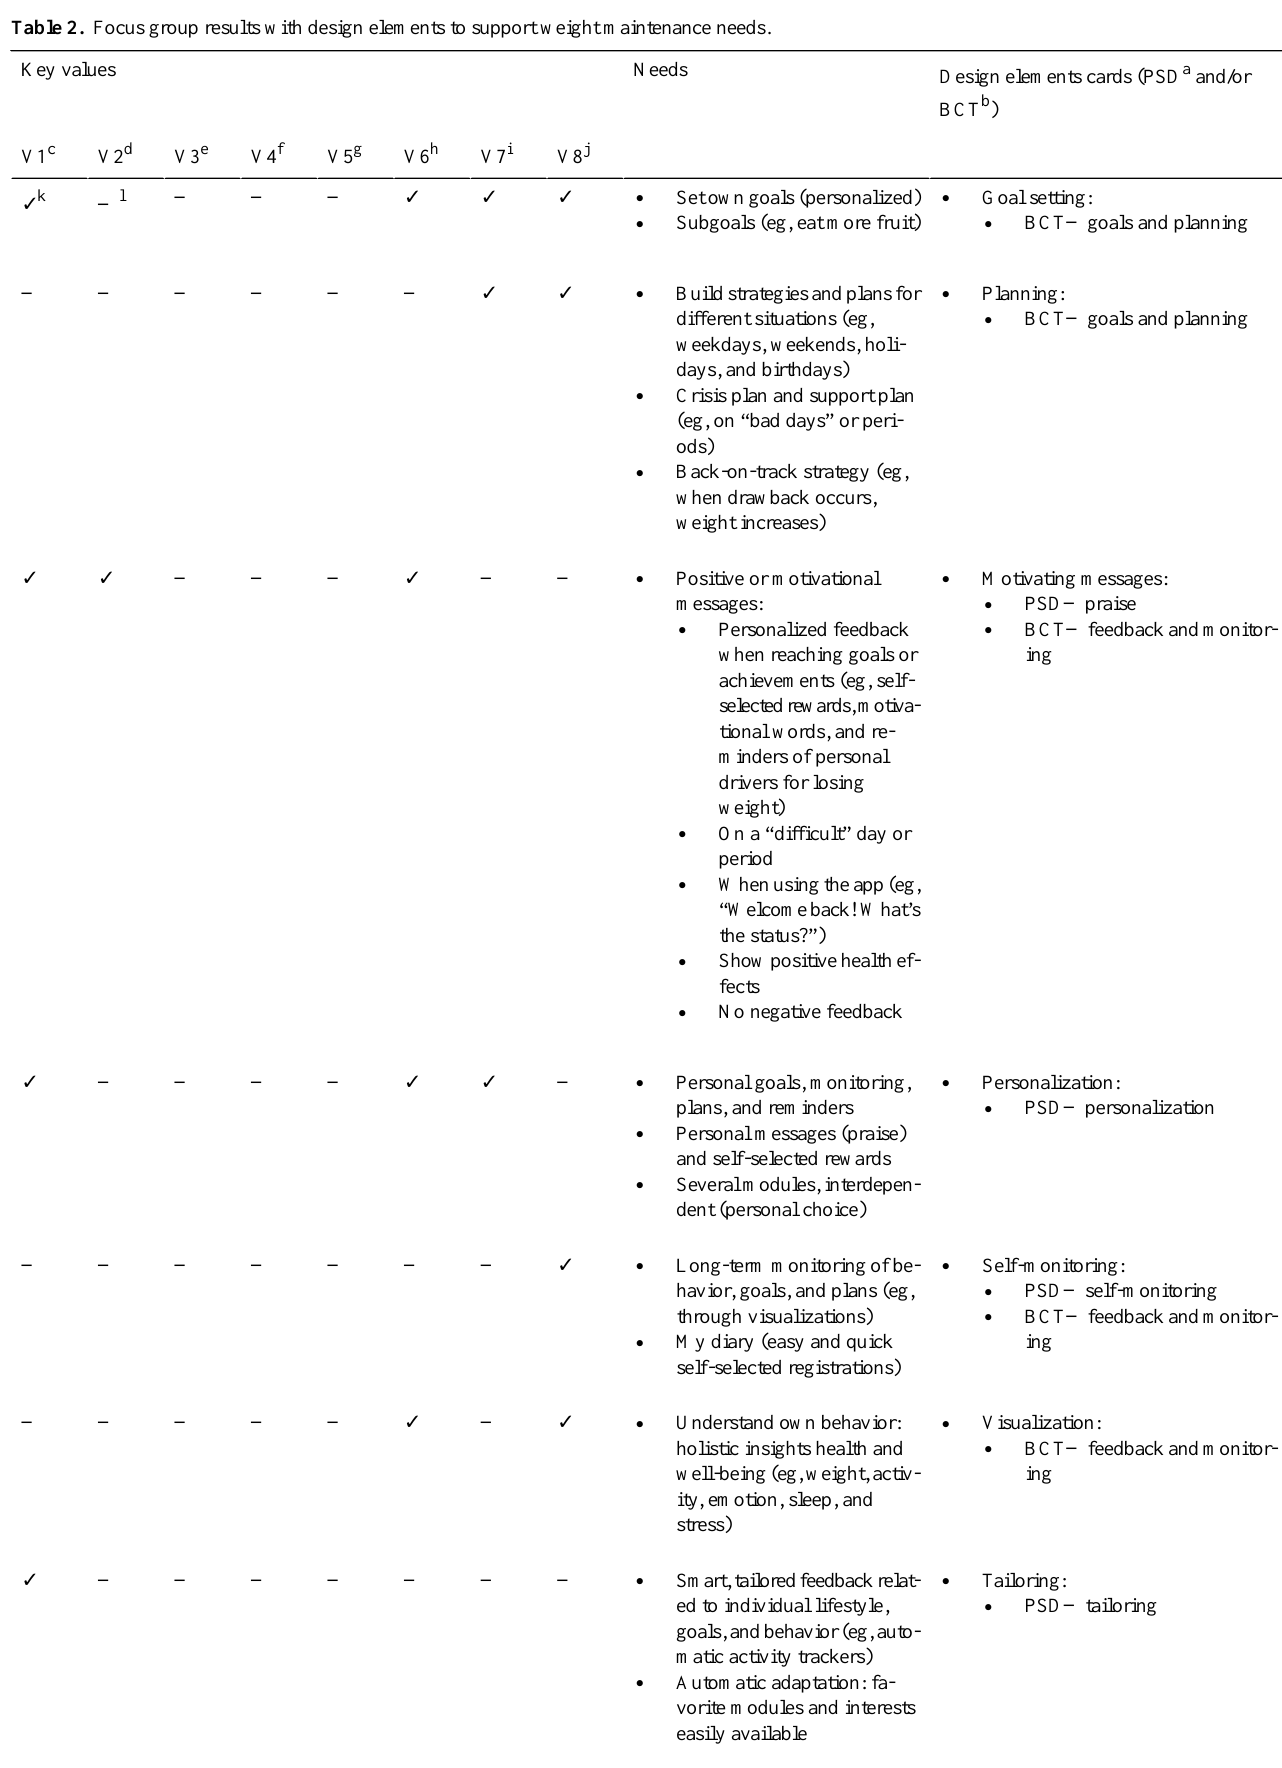
Table 2. Focus group results with design elements to support weight maintenance needs. )NeedsKey